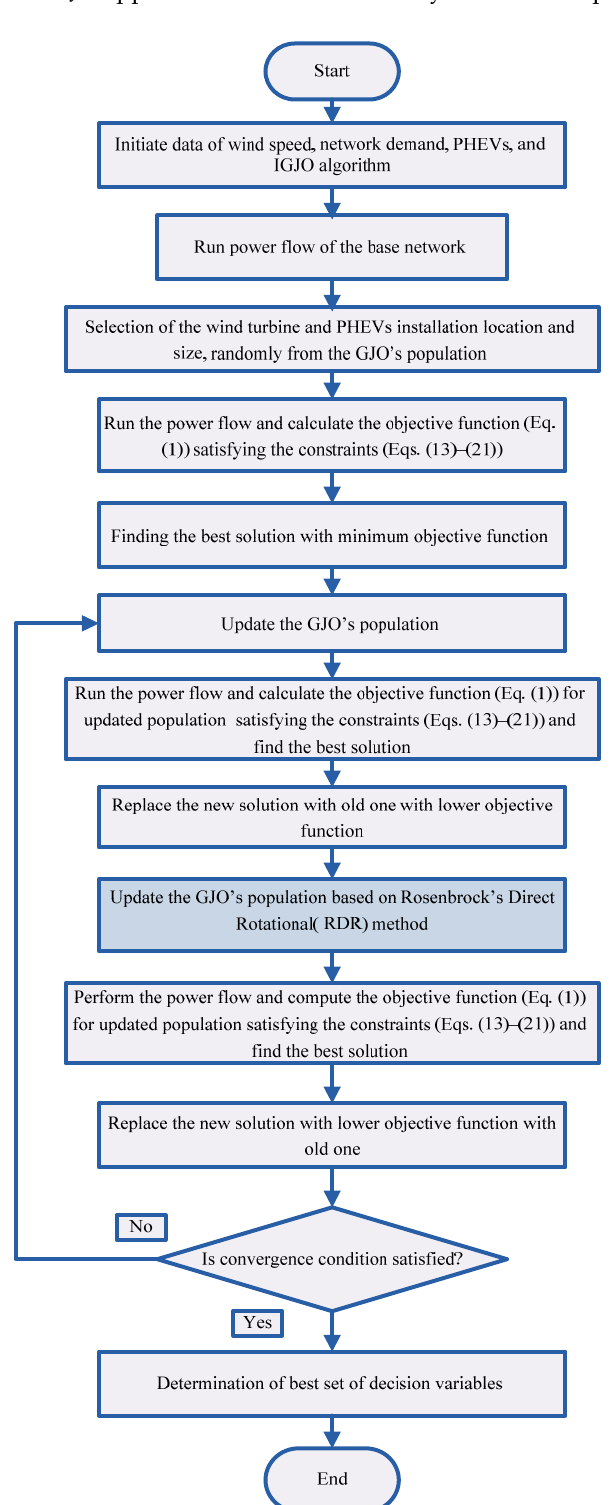
Figure 1. Flowchart of IGJO implementation to solve the problem.